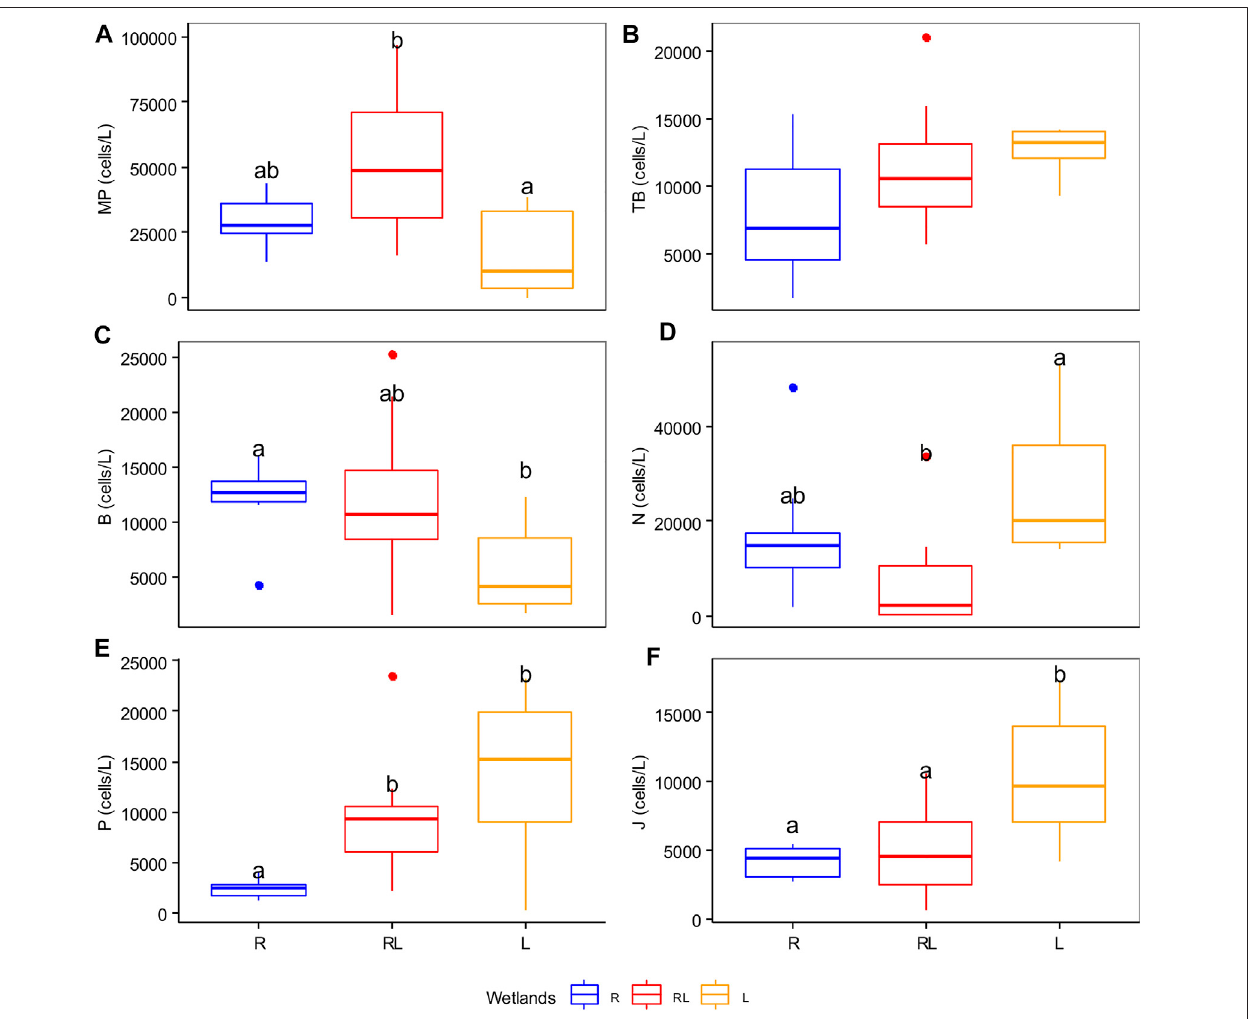
FIGURE7| Boxplotwiththemedian (solidline)fortheabundanceofReynolds functionalgroups (A – F) .Datafromthedryandwet seasonswerecombined.Boxes that have no letter in common signi fi cantly differ from each other.